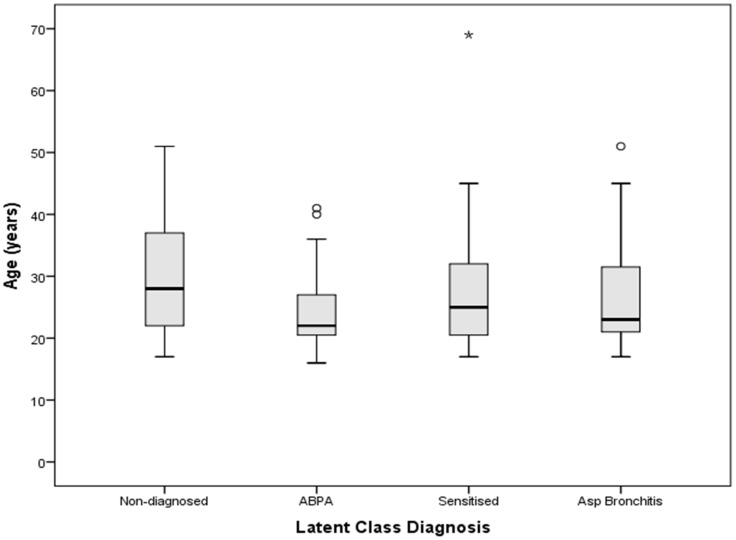
Boxplot to show the difference in ages between the different diagnostic groups of aspergillosis.